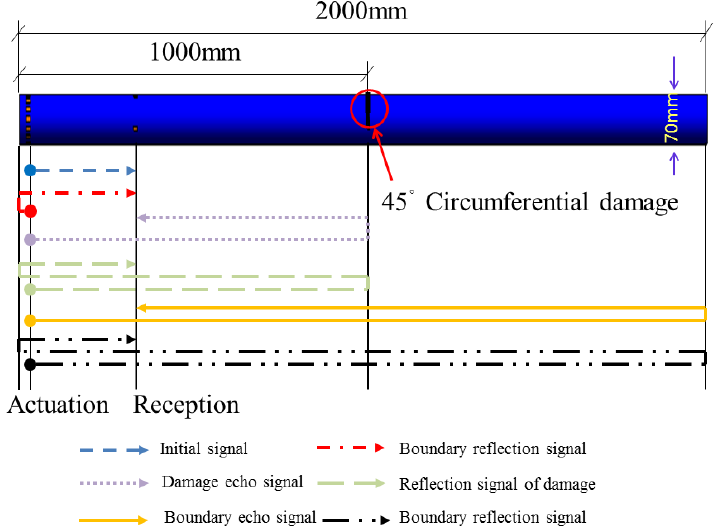
Figure 12. The schematic of signal propagation in the pipe with circumferential damage (45°) in the simulation.